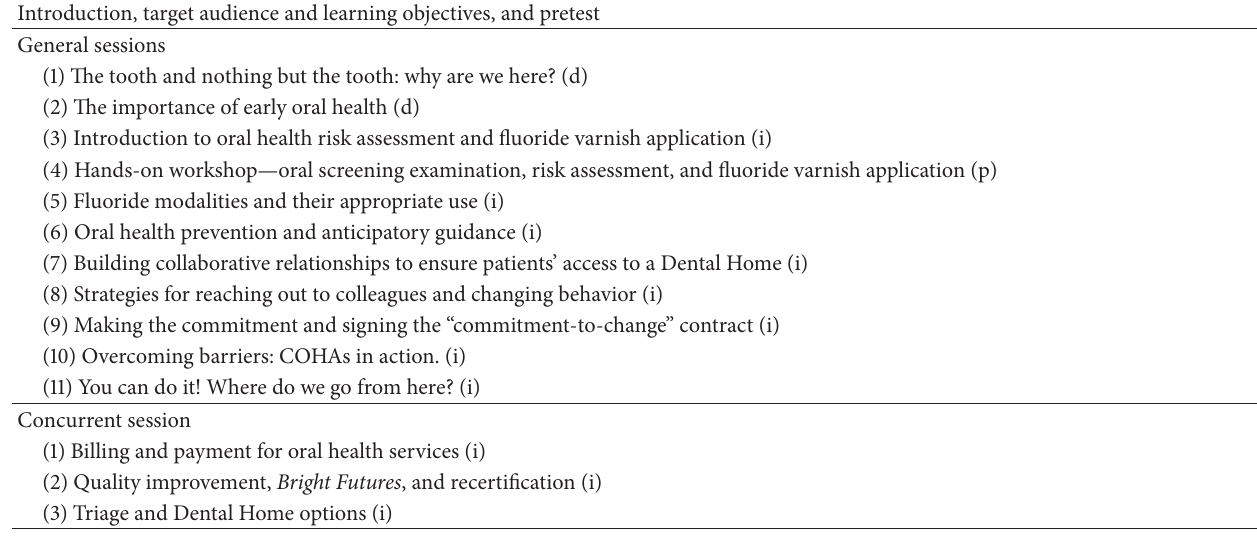
Introduction, target audience and learning objectives, and